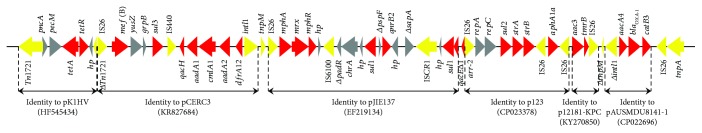
Schematic representation of the MDR region of plasmid pR46-270. Red arrows indicate resistance genes, yellow arrows indicate mobile genetic elements, and gray arrows indicate genes with other functions. Truncated genes are indicated by the “Δ” symbol.